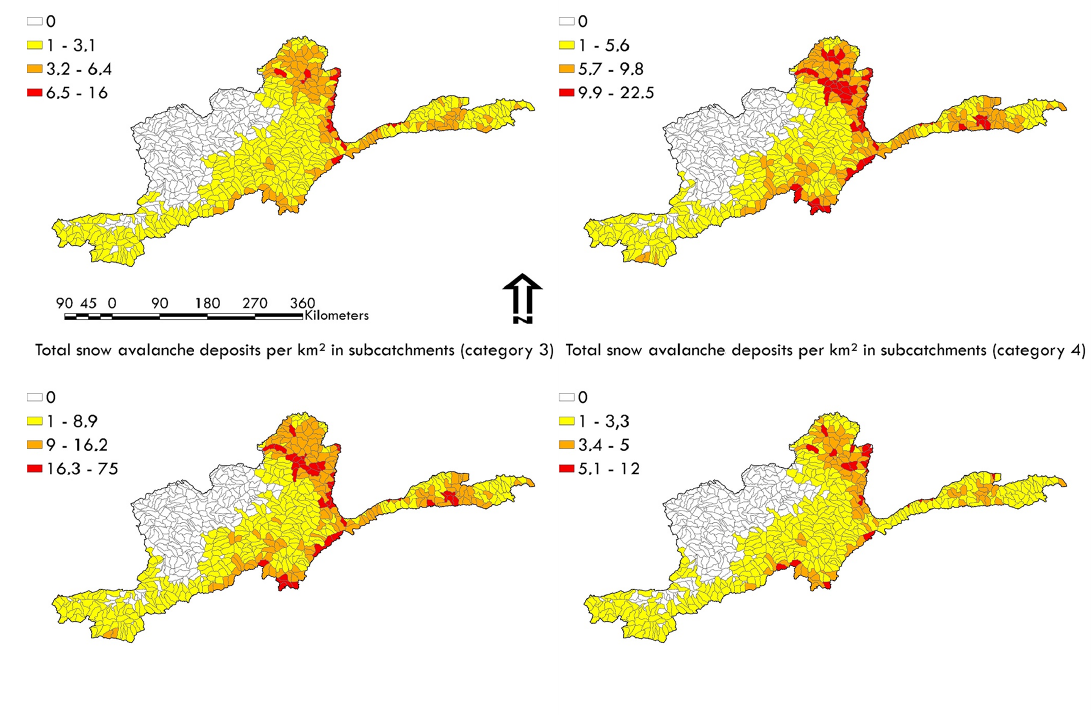
Figure 7. Total avalanche depositional zones per category and per square kilometre in subcatchments during the past 32 years.